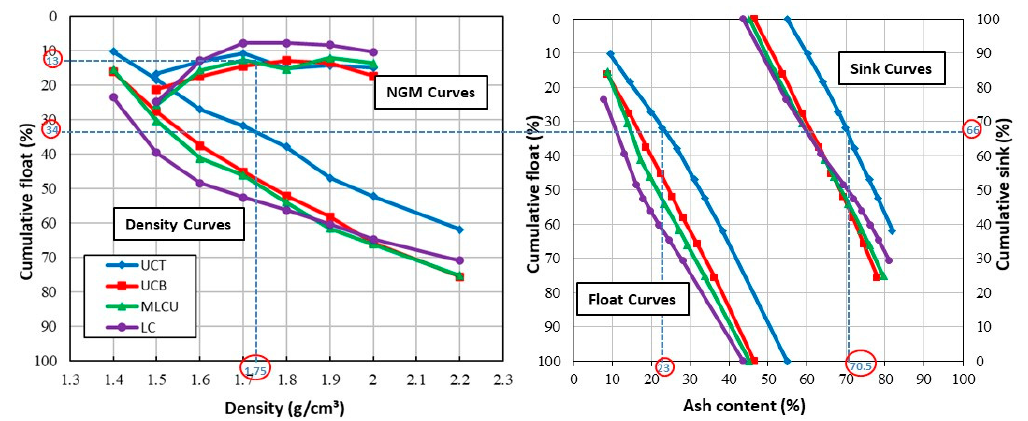
Figure 3. Washability curves (Henry–Reinhardt curves) of the Moatize coal layers (UCT, UCB, MLCU, and